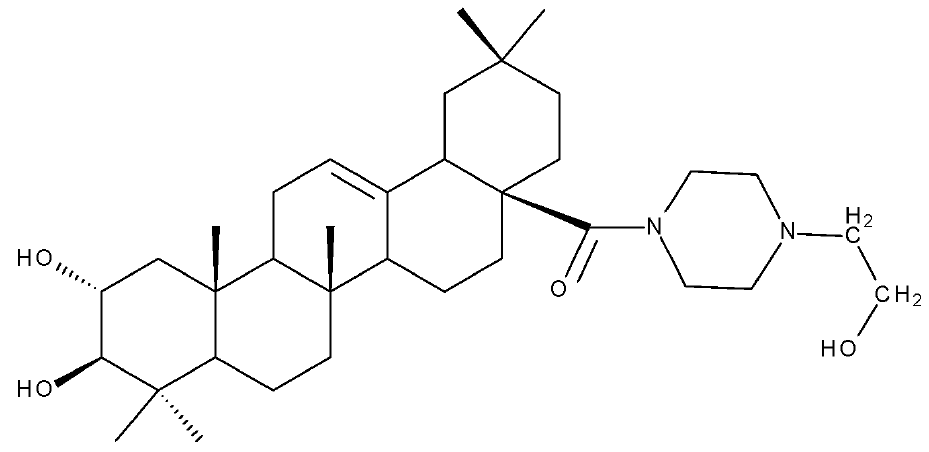
Figure 9. Frequent targets for the derivatization of corosolic acid.